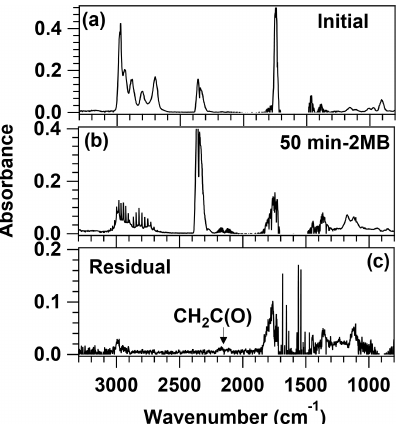
Figure 8. Temporal evolution of 2-methylbutanal (sum of the two identified ions) and the most abundant products measured by PTR- ToF-MS during the 2-methylbutanal + Cl reaction. Vertical dashed line indicates when UV lamps are switched